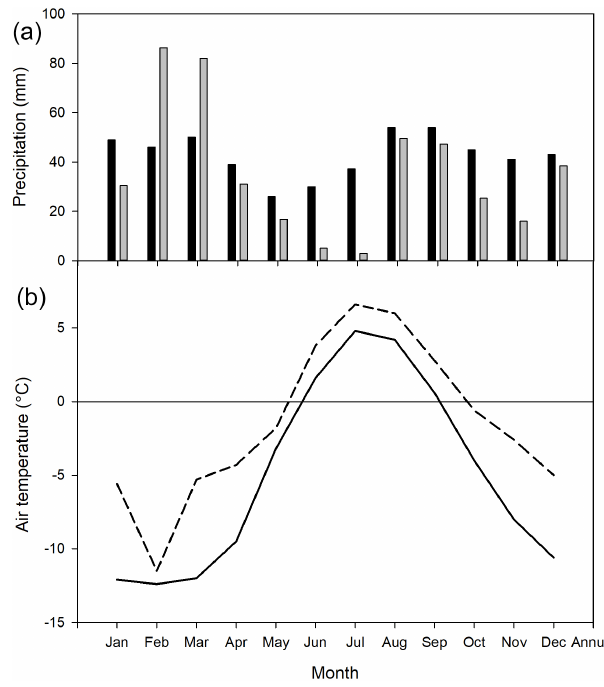
Figure 1. Monthly precipitation (a) : long-term average 1961–1990 shown by black bars and 2015 by grey bars. Data from Barentsburg for January–May and from Isfjord Radio for June–December. Mean monthly air temperature (b) : solid line is long-term average 1961– 1990 and dotted line is 2015. Data from Isfjord Radio, which is located about 1km west of the investigation